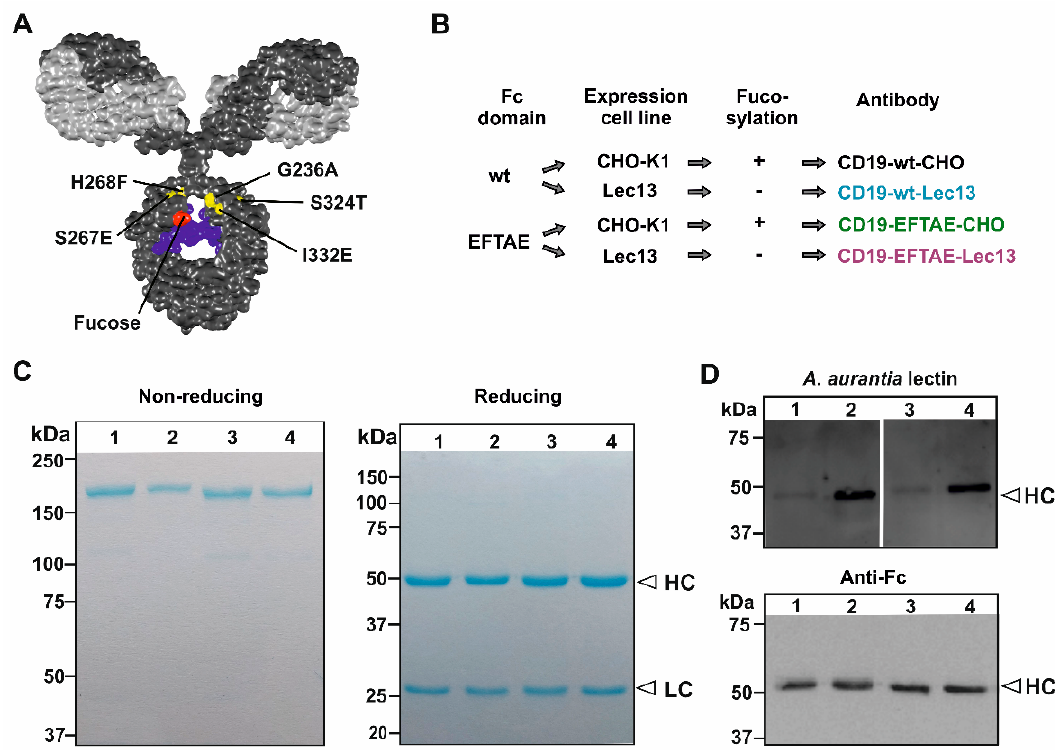
Figure 1. Generation of Fc engineered CD19 antibodies. ( A ) Structural model of an IgG molecule and illustration of amino acid exchanges S267E / H268F / S324T / G236A / I332E (EFTAE modification; in yellow) in the antibody CH2 domain, and the critical fucose residue in red. The light and heavy chains are depicted in light grey and dark grey, respectively. The N297-associated carbohydrate is colored in blue. The model is based on the pdb-file provided by Dr. Mike Clark [42] and was edited employing Discovery Studio Visualizer software (Biovia, San Diego, CA, USA). ( B ) Expression constructs for CD19 heavy chains with native (wt) or with EFTAE modified Fc domain sequences were generated and transfected into CHO-K1 and Lec13 cells for production of fucosylated antibodies (CD19-wt-CHO and CD19-EFTAE-CHO) as well as their afucosylated counterparts (CD19-wt-Lec13 and CD19-EFTAE-Lec13), respectively. ( C ) After purification by affinity chromatography antibodies were analyzed by SDS-PAGE and Coomassie blue staining under non-reducing (left gel) or reducing (right gel) conditions. Amounts of 1–2 µ g protein were loaded on 6% and 12% polyacrylamide gels, respectively (Lanes: (1) CD19-EFTAE-Lec13, (2) CD19-EFTAE-CHO, (3) CD19-wt-Lec13, (4) CD19-wt-CHO). Results from one representative experiment are shown ( n = 3). HC, heavy chain; LC, light chain. ( D ) The fucosylation status of the di ff erent antibody versions was determined by lectin blot experiments employing biotinylated A. aurantia lectin and HRP-conjugated neutrAvidin protein (upper panel), indicating that fucose was almost absent in antibodies produced in Lec13 cells. As a control, antibody heavy chains (HC) were detected in Western Transfer experiments with an HRP-coupled anti-human IgG Fc antibody (lower panel). Results from one representative experiment are shown ( n = 3). Lanes: (1) CD19-EFTAE-Lec13 (2) CD19-EFTAE-CHO (3) CD19-wt-Lec13 (4) CD19-wt- CHO).